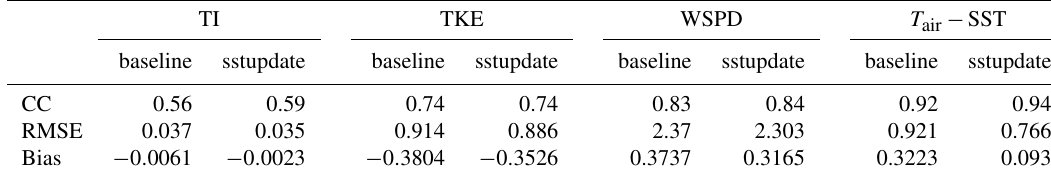
Figure 5. Scatterplots depicting the relationship between simulated (baseline) WSPD and sub-grid TI with color shadings for representing 80m TI and TKE errors in (a) and (b) , respectively. Table 2. Metrics including correlation coefficient (CC), root mean square error (RMSE), and bias of 80m TI, TKE, WSPD, and air–sea temperature difference are given as computed for baseline and sstupdate